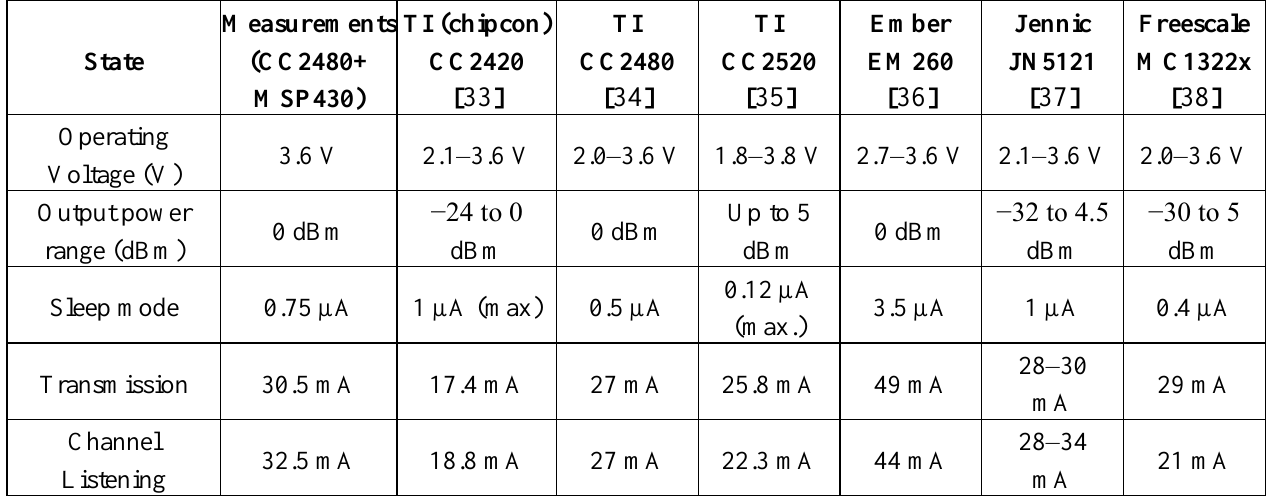
Table 2. Comparison of the performed measurements with the current consumption (at 0 dBm) reported in the datasheets of different commercial 802.15.4 compliant